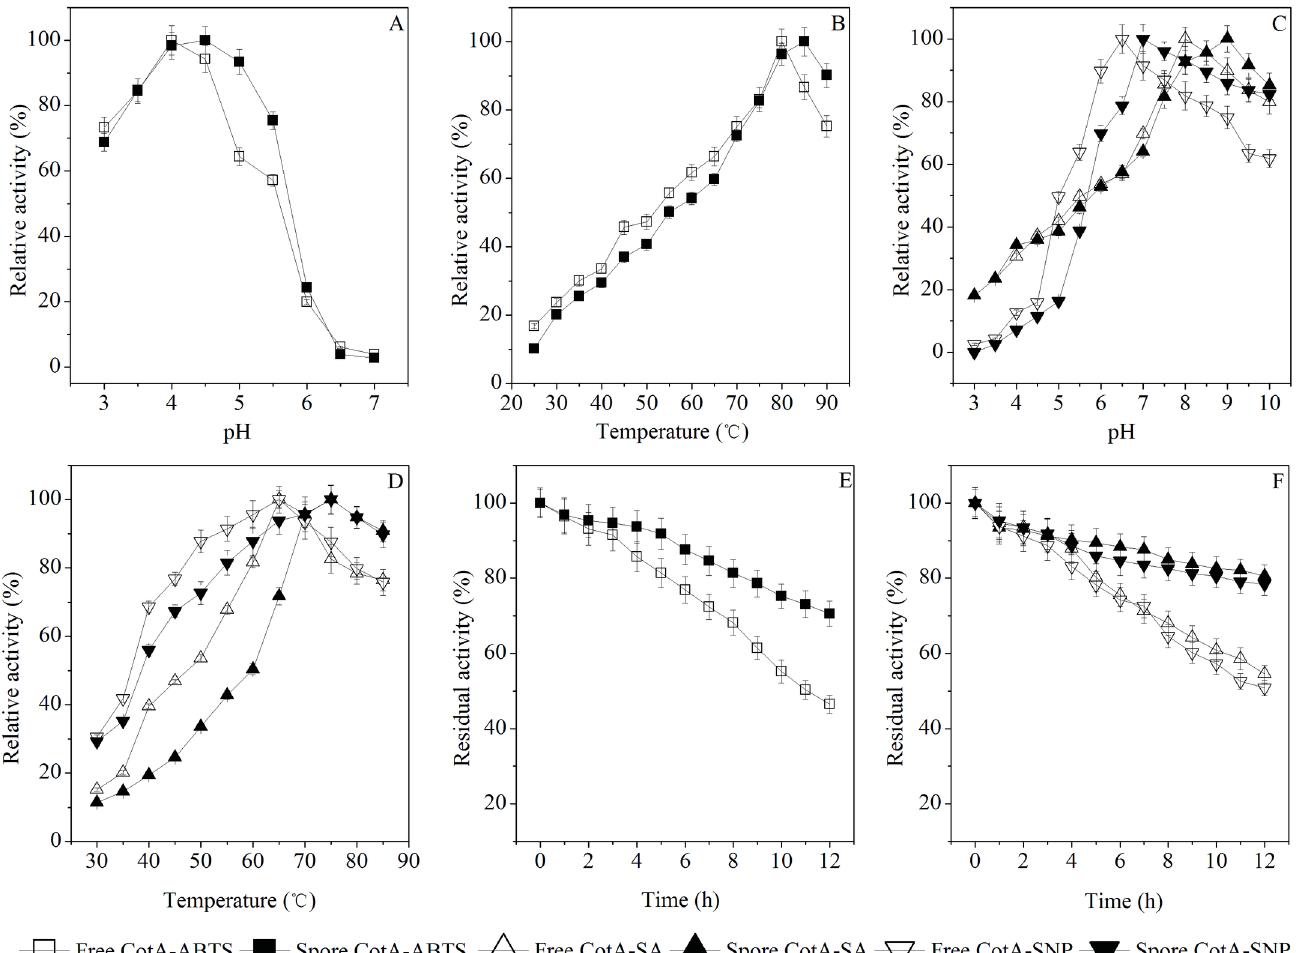
Fig 2. Optimal activity of the free and spore CotA. Laccase activity toward ABTS under different pH (A) and temperature (B) conditions. Laccase activity toward SA and SNP under different pH (C) and temperature (D) conditions. Stability of laccase activity toward ABTS (E), SA and SNP (F) under optimal pH and temperature